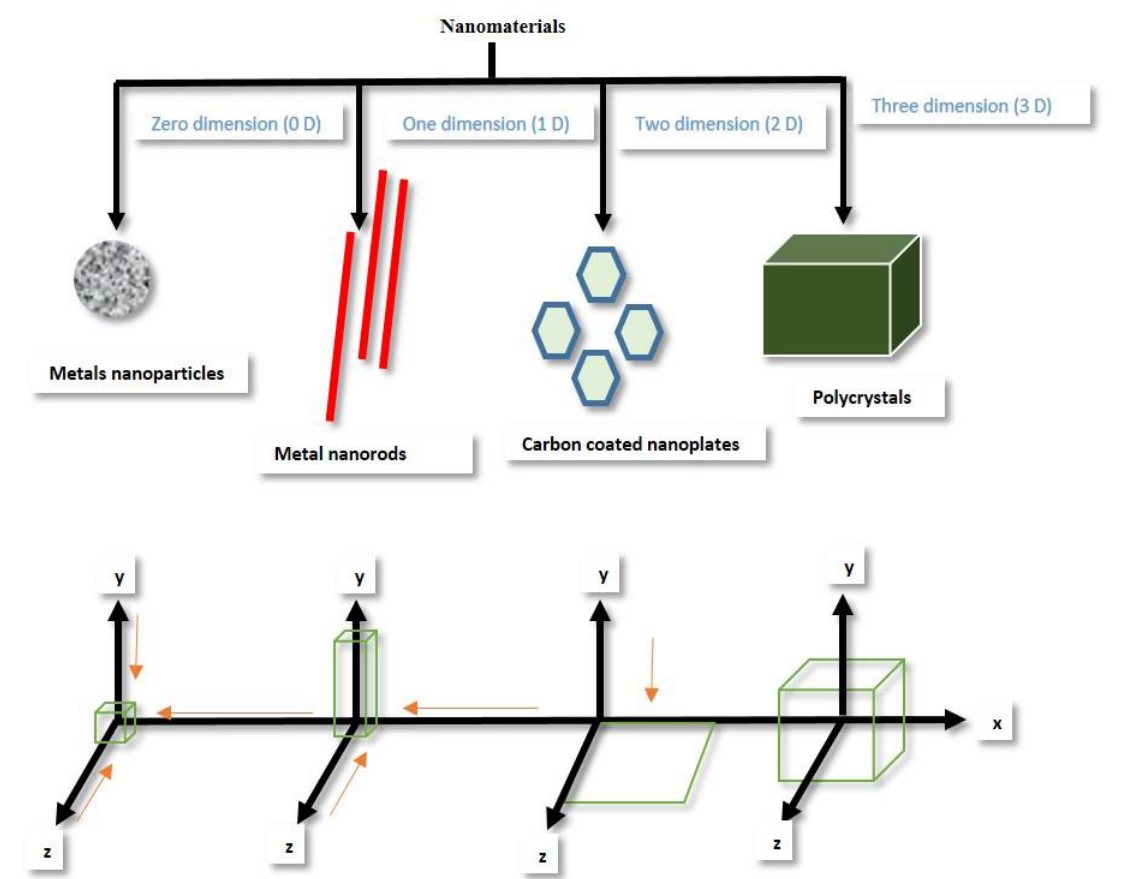
Figure 2. Schematic diagram of nanomaterials based on the dimension.